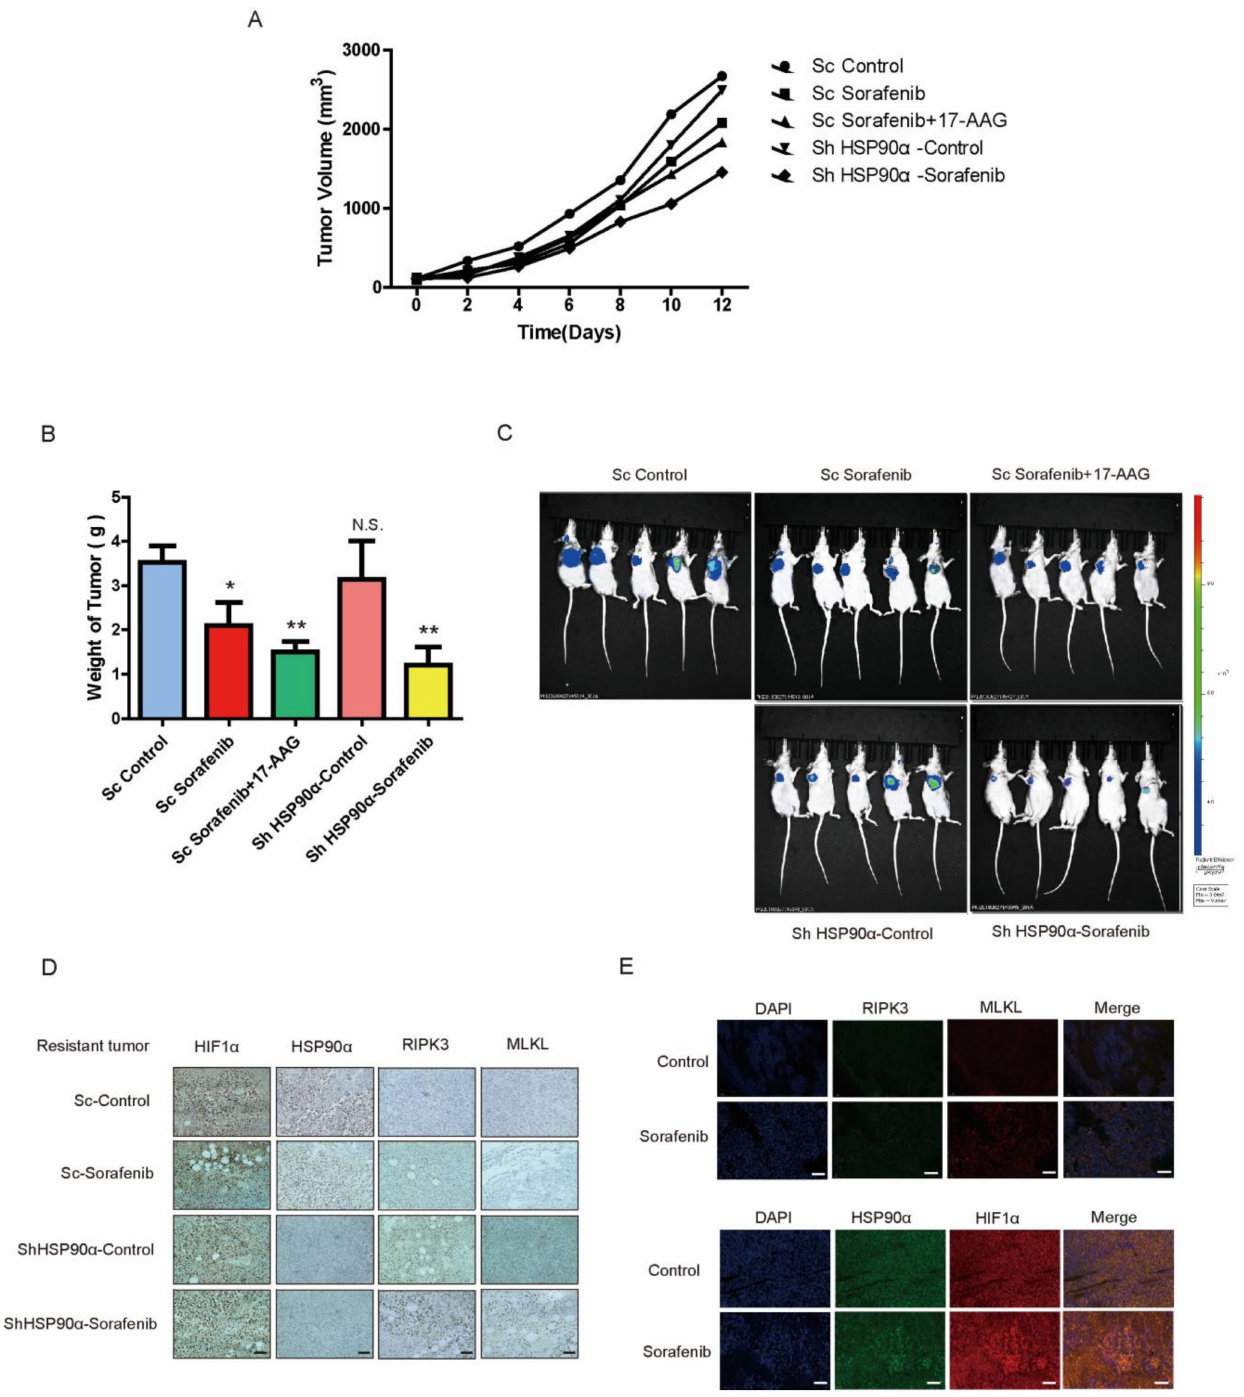
Figure 6. HSP90 α can be a Useful Target in Sorafenib Resistance Therapy In Vivo. ( A ) Tumor volume was recorded in primary Sorafenib resistant xenograft model. ( B ) Tumor weight was recorded in primary Sorafenib resistant xenograft model. The results were shown as mean ± SEM from three independent experiments. * p < 0.05, ** p < 0.01, ns, not significant. ( C ) Bioluminescence images of the primary Sorafenib resistant xenograft model. ( D , E ) The expression of HIF1 α , HSP90 α and necroptosis pathway in tumors detected by IF and IHC. Scale bar = 800 µ